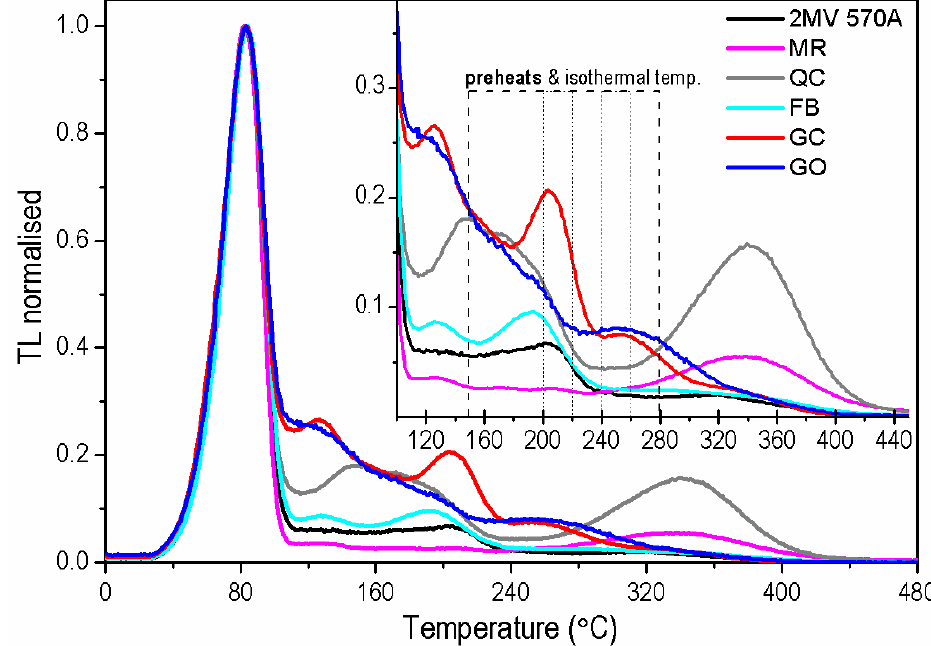
Figure 1. Normalized TL glow curves measured for one aliquot of each sample after irradiation with a dose of 1000 Gy. The inset shows the same data for the high-temperature range with the marked preheat (dashed lines) and storage temperatures (dotted line) used in experiments. TL glow curves were measured immediately after irradiation with heating rate of 2 Ks −1 and standard background subtraction was performed for each aliquot.